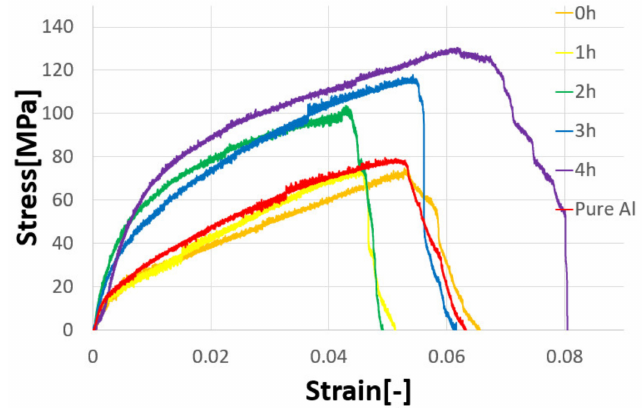
Figure 10. Stress–strain curves for Al and 0.5 mass.% CNT / Al